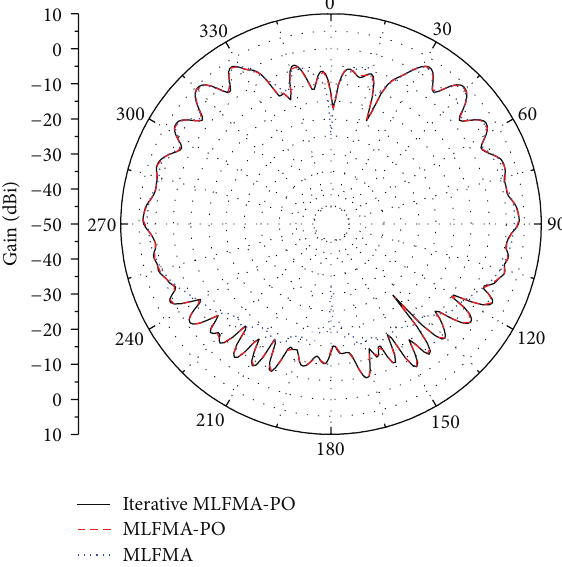
Figure6:Thefar-fieldgainpatterninYOZplaneofthewireantenna mounted on ship model.